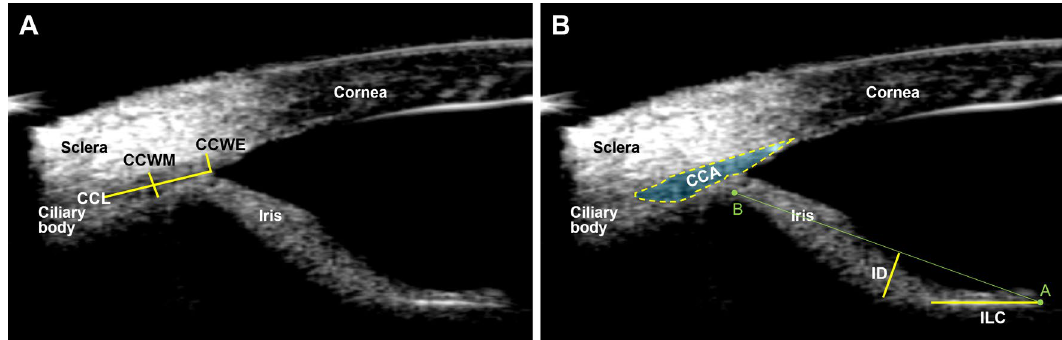
Figure 5. Measurements of UBM parameters ( A : CCWE, CCWM, and CCL. B : CCA, ILC, and ID). CCWE, ciliary cleft width at the entrance; CCWM, ciliary cleft width at the middle; CCL, ciliary cleft length; CCA, ciliary cleft area; ILC, iridolenticular contact; ID, iris